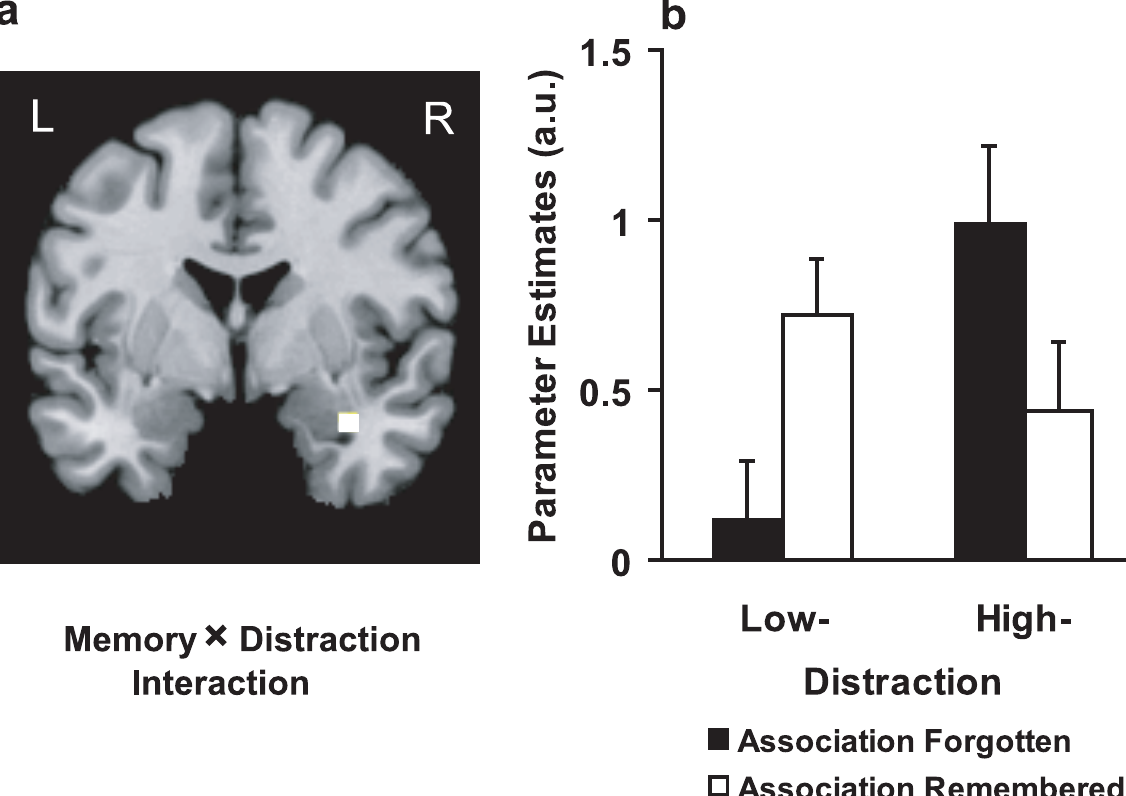
Figure 4. The interaction between distraction (low and high) and memory (Association forgotten and Association remembered). a , An effect has been revealed in the right anterior hippocampus (MNI 33 -6 -21, SVC, p =0.021). Image is thresholded at p , 0.001 uncorrected, for displaying purposes. L, left; R, right. b , We extracted the beta values from this region just to depict the direction of the interaction revealed. As can be seen, the interaction was based on a positive subsequent memory effect when distraction was low and a negative subsequent memory effect when distraction was high. Error bars represent SEM.